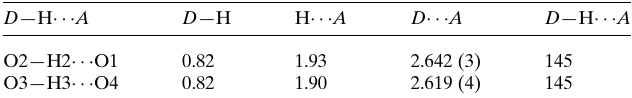
Table 1 Hydrogen-bond geometry (A˚ , (cid:2) ) for ( 1 ).